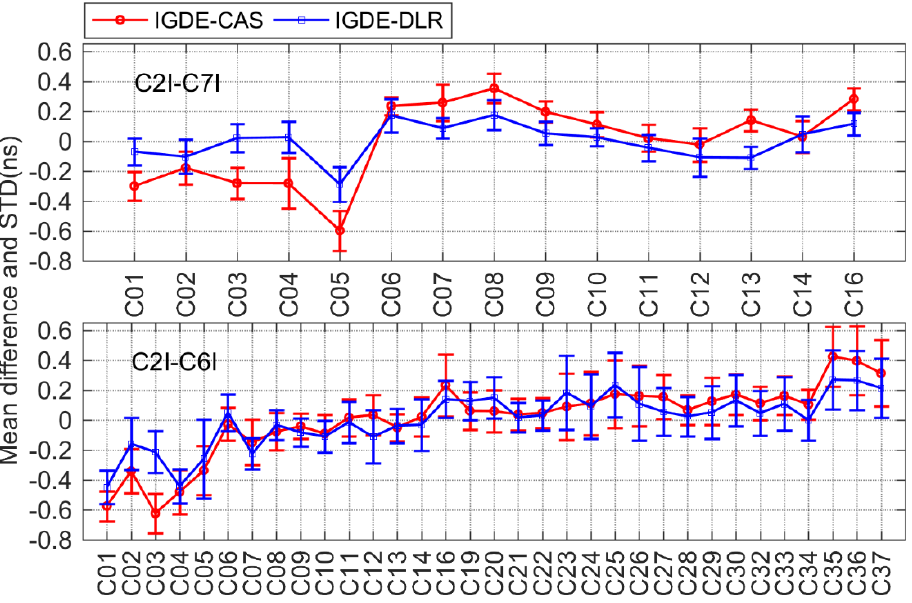
Figure 9. Mean difference and STD of BDS DCB between IGDE and MGEX products. For Galileo, there were six types of DCBs compared with CAS and DLR, including C1X-C5X, C1X-C7X, and C1X-C8X, as well as C1C-C5Q, C1C-C7Q, and C1C-C8Q. Figure